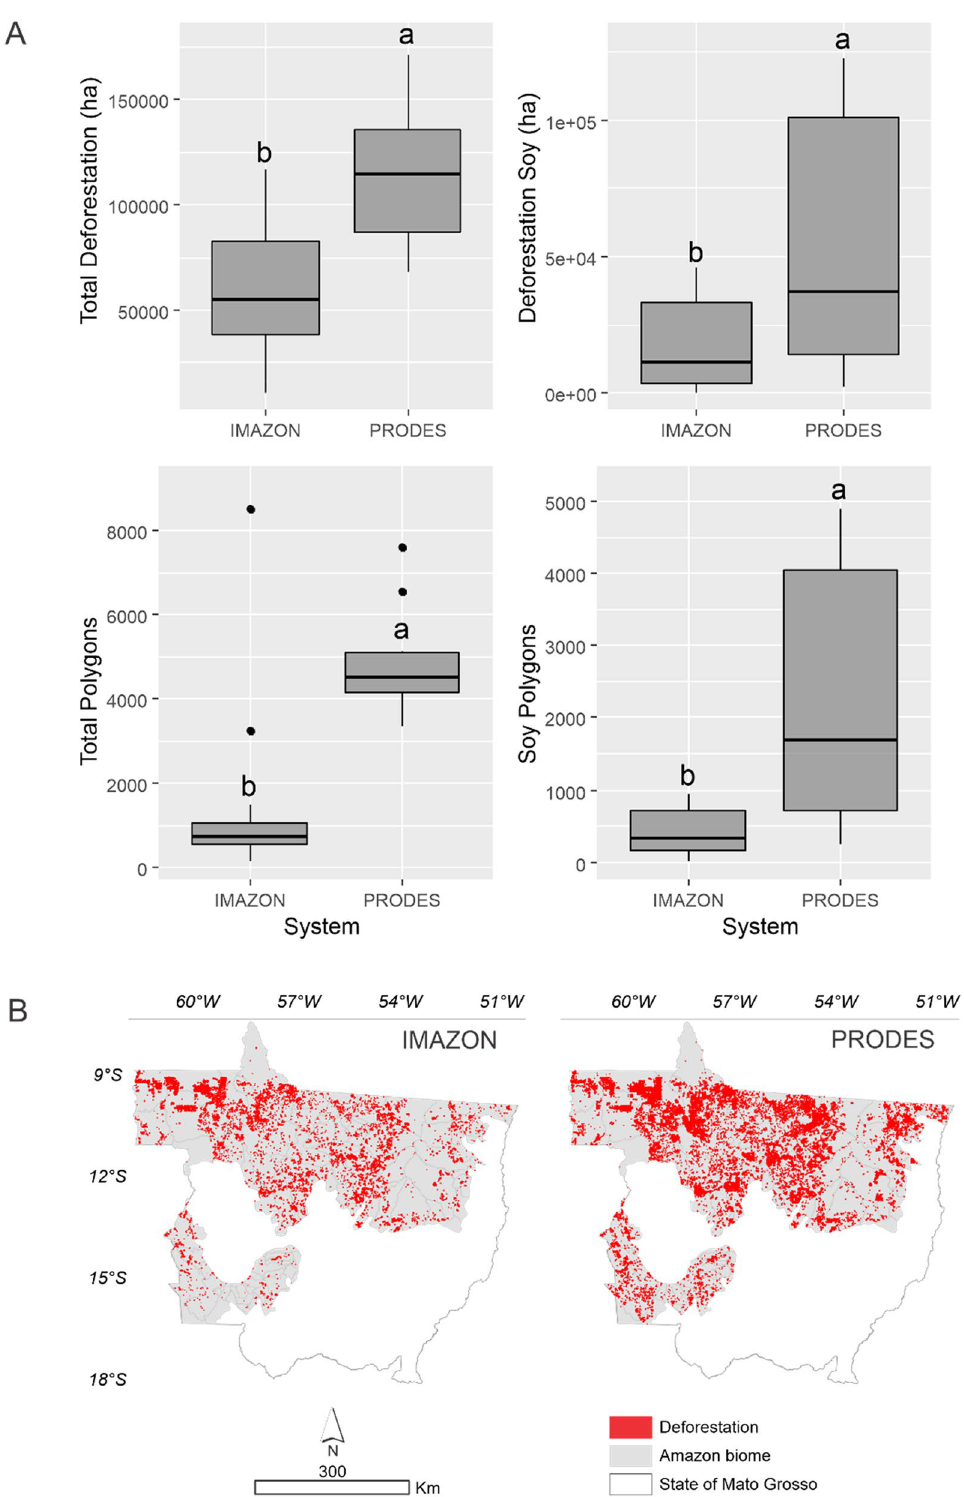
Figure 3. Boxplot for the variables total deforestation, deforestation for soybean planting, total polygons, and polygons for soybean planting obtained with the Imazon and PRODES monitoring systems ( A ). Means followed by different letters in the same figure differ from each other by the t-test at 5% probability and cumulative deforestation from August 2008–2019 by ImazonGeo and PRODES ( B